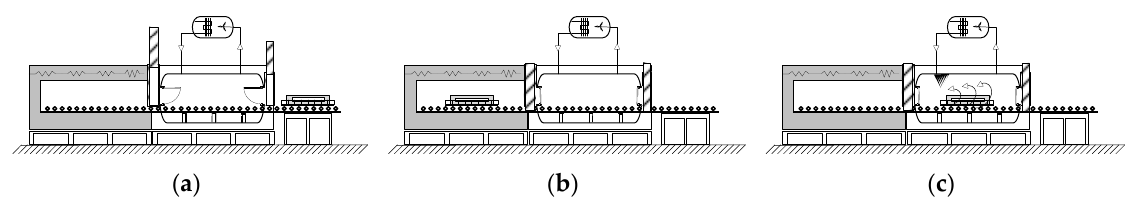
Figure 4. Operating sequence of the furnace with the nitrogen cooling system: ( a ) Before workpiece loading; ( b ) workpiece loading and heating; ( c ) nitrogen cooling.